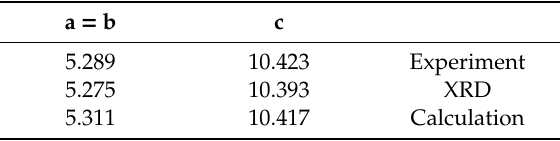
Table 2. Optimized lattice parameters (in Å ) of bulk chalcopyrite.